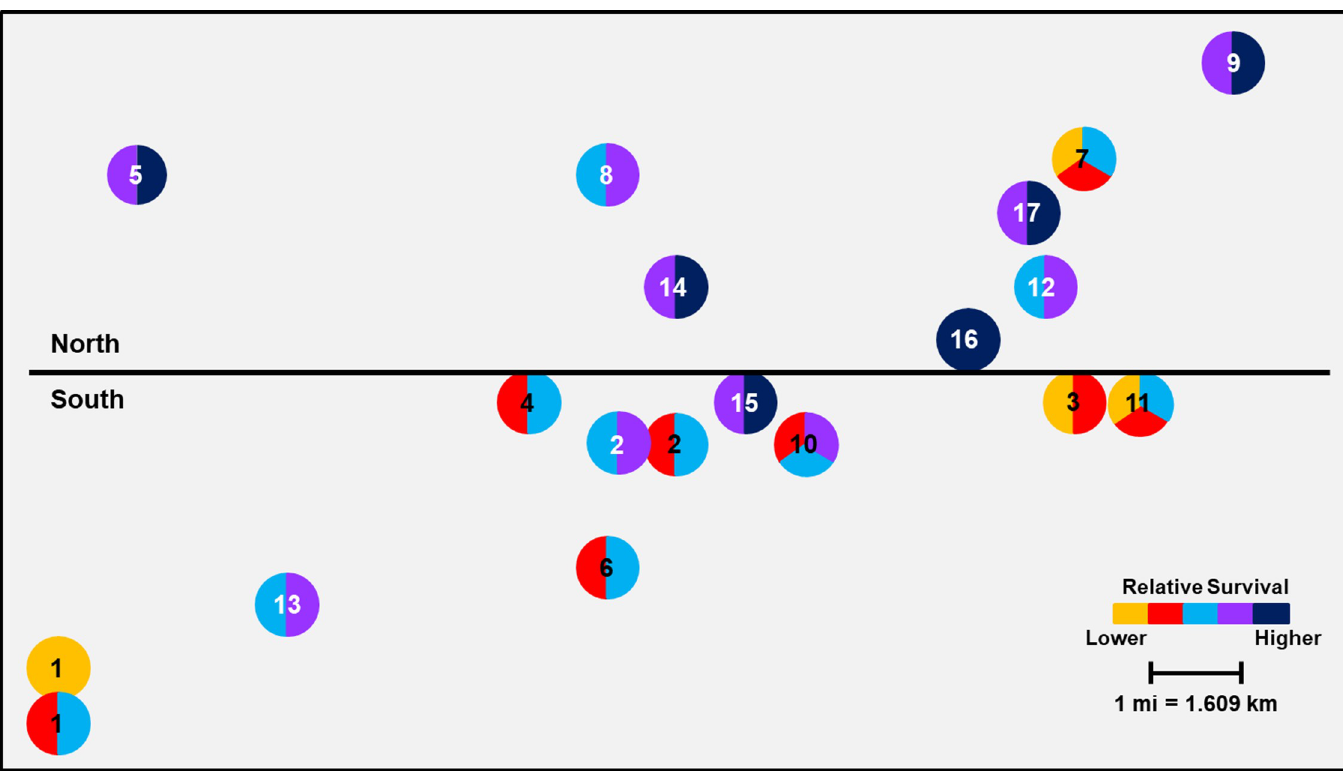
Fig 6. Spatial variation in mean Cry3Bb1 survival of WCR larvae among sampling sites in Keith County. Mean proportional survival ranged from 0.04 ± 0.01 to 0.66 ± 0.06. Circles containing the same color(s) are not significantly different (generalized linear model, P > 0.05; LSMEANS